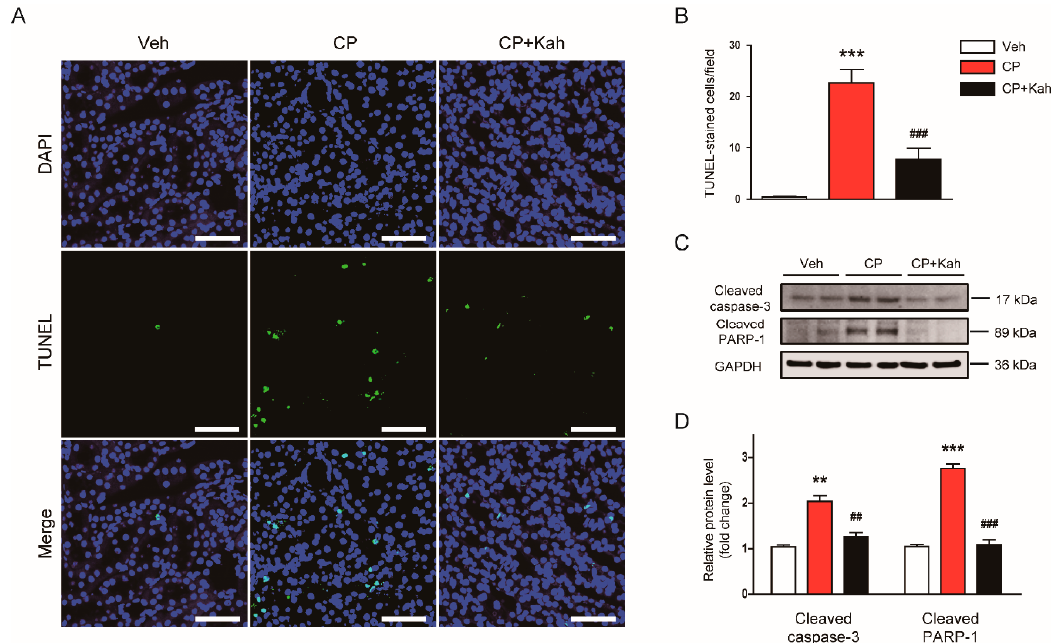
Figure 7. Effect of kahweol on apoptotic cell death in cisplatin-injected mice. ( A ) TdT-mediated dUTP nick end labeling (TUNEL) assay on kidney tissues. Scale bar = 50 μ m. To stain nuclei, DAPI was used. ( B ) Number of positively stained cells. ( C ) Western blotting of the proteolytic cleavage of caspase-3 and poly(ADP-ribose) polymerase-1 (PARP-1) proteins. ( D ) Quantification of Western blots for the proteolytic cleavage of caspase-3 and PARP-1. GAPDH was used as an internal control. n = 8 per group. ** p < 0.01 and *** p < 0.001 vs. Veh. ## p < 0.01 and ### p < 0.001 vs.